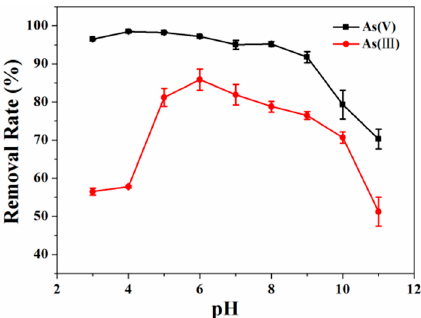
Figure 3. Effect of pH on the removal of As( Ⅲ / Ⅴ ) (experimental conditions: pH = 3–11, dose = 1 g/L, initial concentration = 5 mg/L, T = 25 °C), Y error bars indicate the standard deviation of each data point ( n = 3).